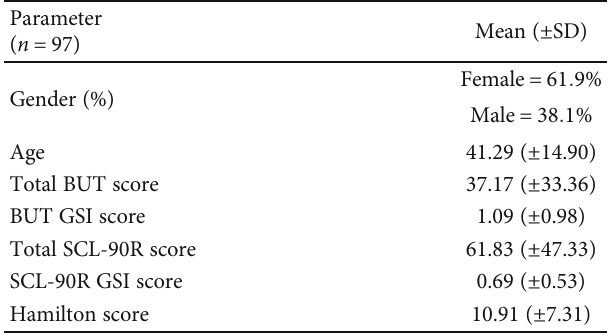
Descriptive table. Results are expressed in mean ± SD . BUT: Body Uneasiness Test (BUT); SCL90R : Symptom Checklist-Revised; HAM-A: Hamilton Anxiety Rating